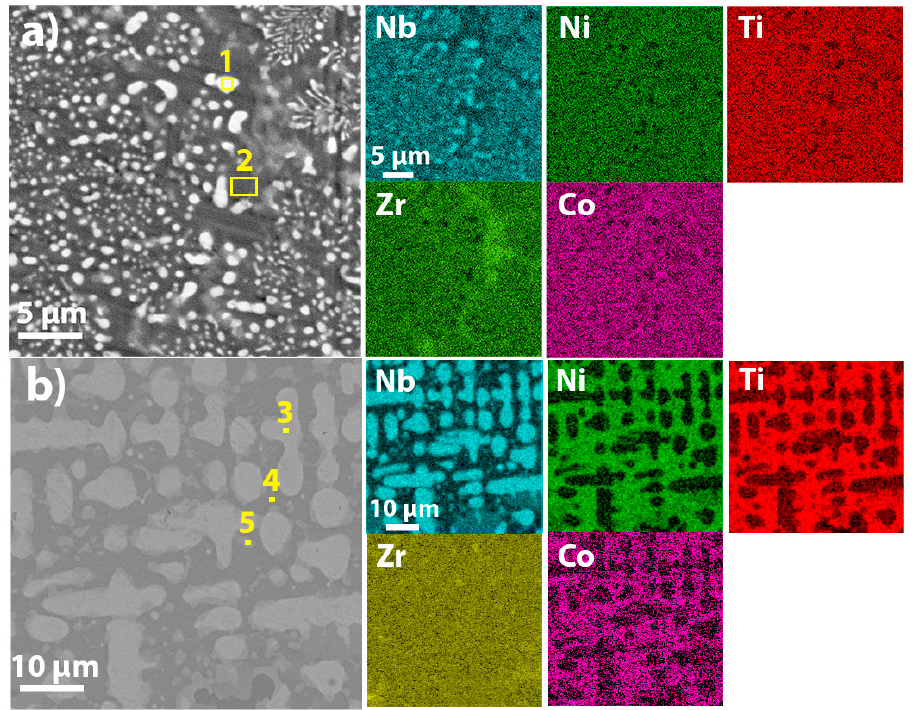
Figure 3. SEM images of Nb 20 Ni 20 Ti 20 Zr 20 Co 20 ( a ) and Nb 40 Ni 25 Ti 18 Zr 12 Co 5 ( b ) HEAs and corresponding EDS maps. Table 1. Elemental concentration in different regions as depicted in Figure 3. Concentration, at. % Sample Region Nb Ni Ti